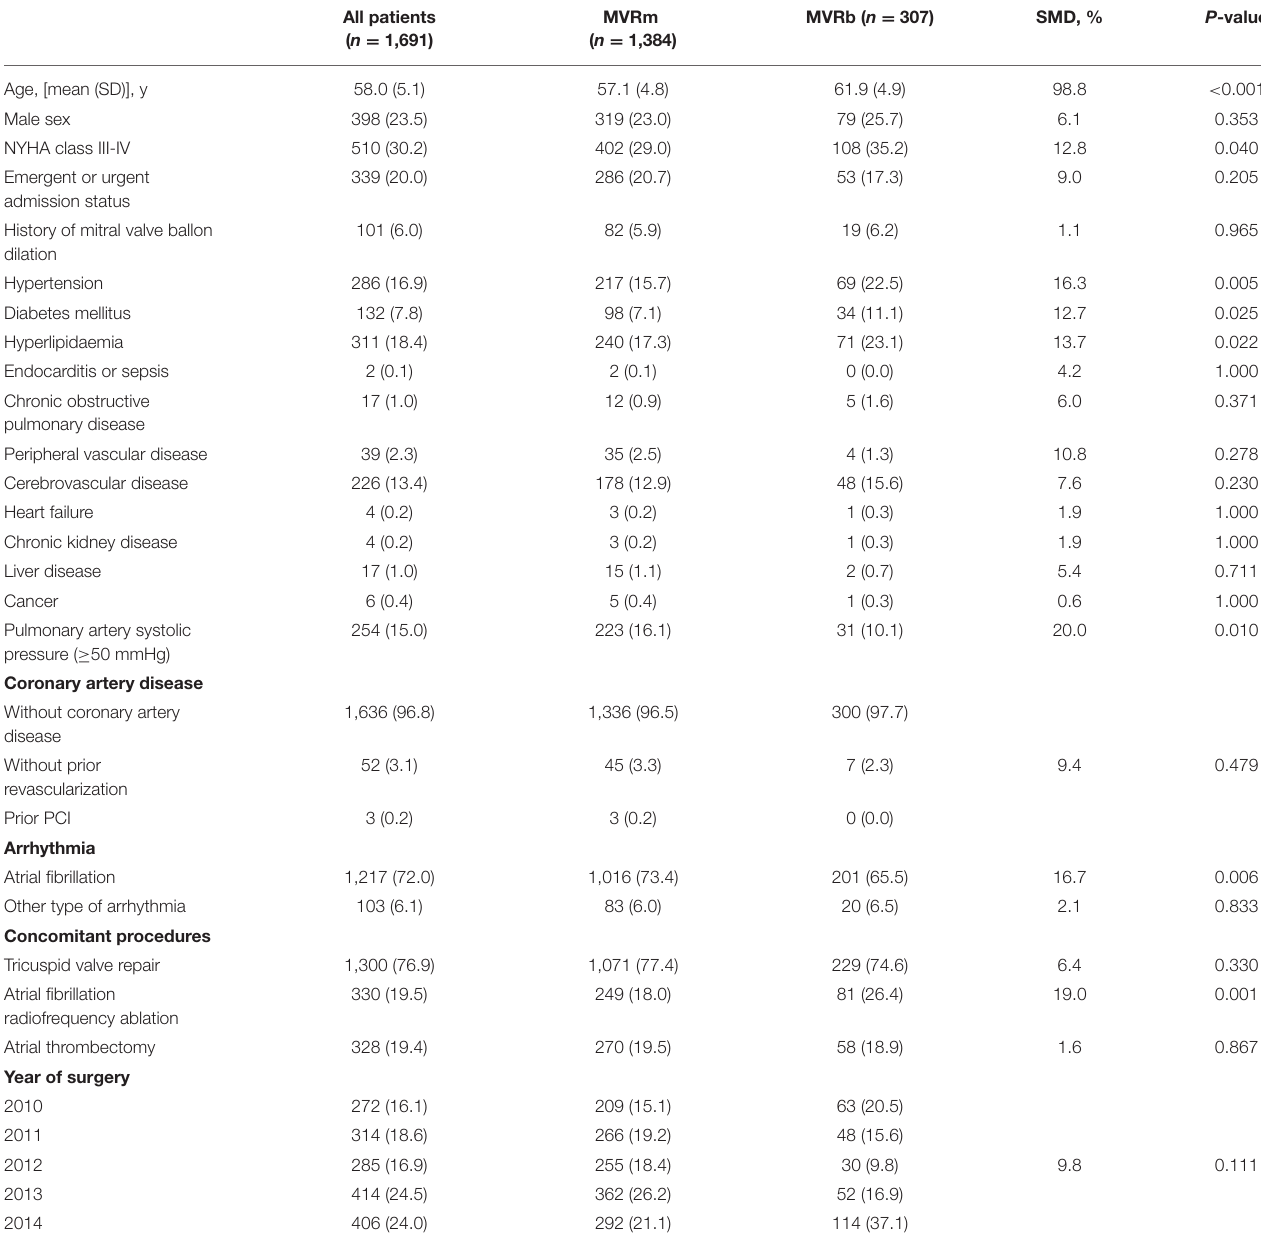
TABLE 1 | Patient baseline characteristics in the overall cohort according to type of mitral valve replacement.